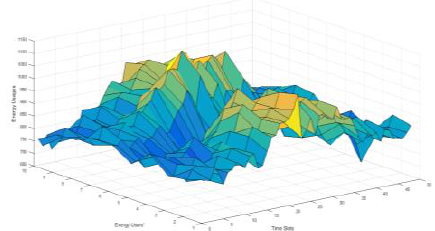
Figure 14. Monthly energy usages of the users’